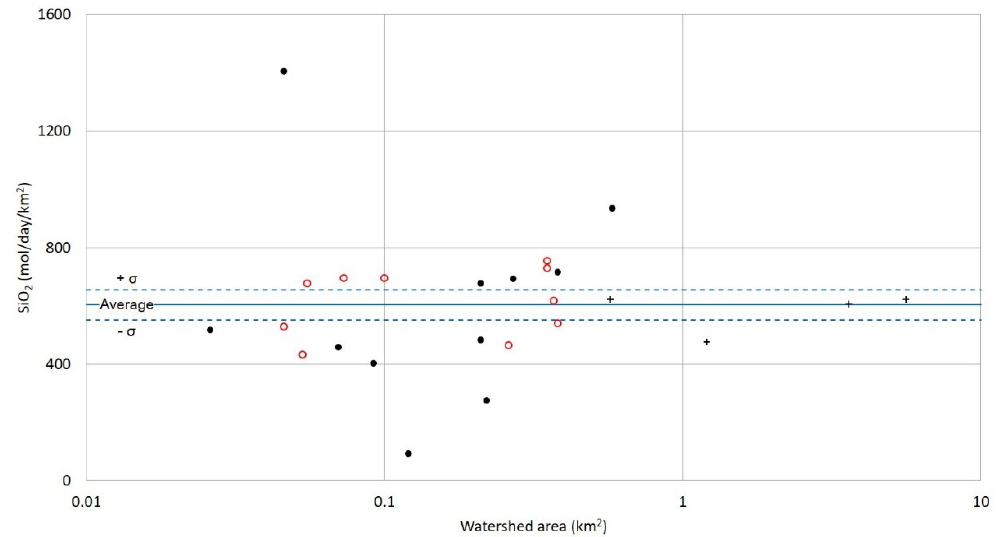
Figure 5. The relationship between the watershed area (km 2 ) and the silica fluxes (mol/day/km 2 ). (In Figure 5, the black circle shows the data of the left bank tributaries, the red circle shows the data of the right bank tributaries and the plus sign shows the mainstream data. The blue line shows the average silica flux of all data, the σ represented the standard error from the average.)